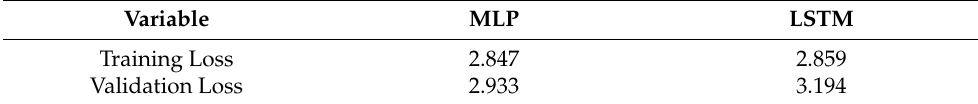
Figure 18. Training and validation losses of the LSTM model in the holdout method. Table 2. Training and validation losses of the last epoch in the holdout method.